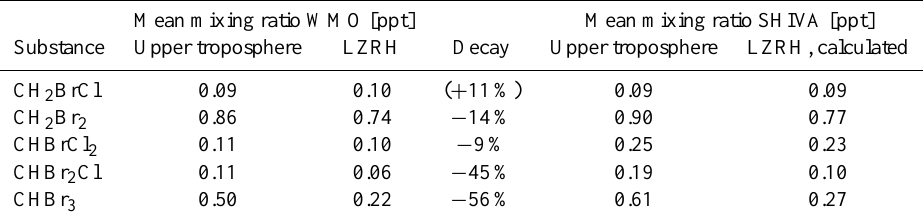
Table 11. Mean mixing ratios of the VSLS in the upper troposphere and the LZRH. The decay shows the decrease in mixing ratio between the upper troposphere and the LZRH given in Montzka and Reimann et al. (2011), denoted as WMO. With these decay rates, the expected mixing ratios for the LZRH during SHIVA are calculated. The mixing ratio of CH 2 BrCl is kept constant, as there is no physical indication of an increase as given in the WMO data.